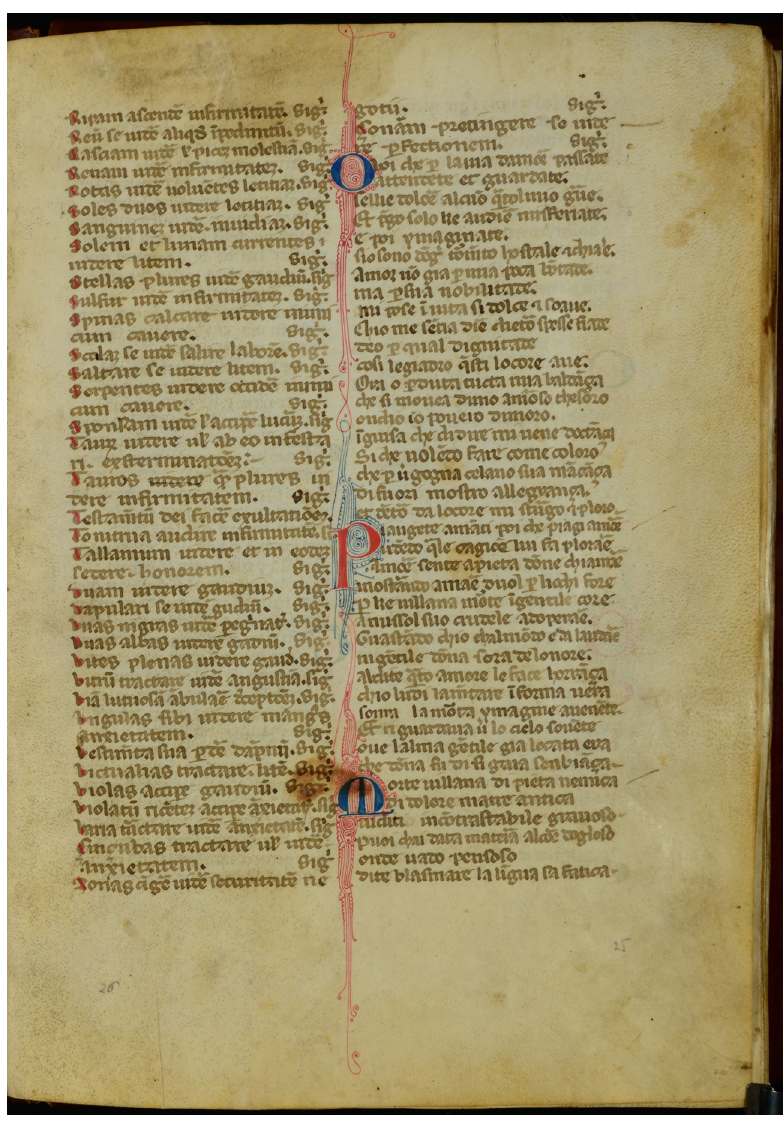
Fig. 2: Florence, The Biblioteca Medicea Laurenziana, MS Martelli 12, fol. 25r. Reproduced with permission of MiBACT. Further reproduction by any means is